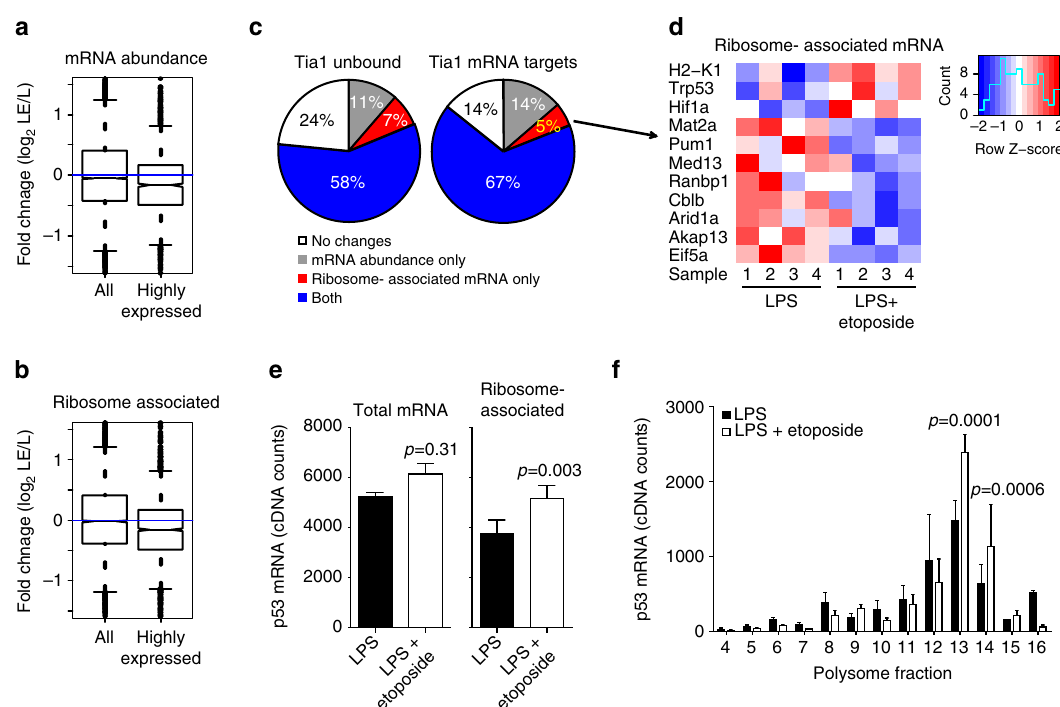
Fig. 4 DNA damage induces mRNA translation of p53 in B cells. a , b Global analysis of changes in mRNA abundance ( a ) and mRNA association with ribosomes ( b ) after treatment with etoposide of LPS-activated B cells. Box plots were generated with data from all genes or from only a selection of highly expressed genes. These genes were selected after calculating the mean number of normalized reads annotated to each gene in our mRNAseq and in our PolyRibo-3 ′ RNA-seq libraries. Then, windows of expression were generated by adding or subtracting 1000 counts (mRNAseq window in log2 is 11.09 < 11.63 (mean) < 12.03; PolyRibo-3 ′ RNA-seq window in log2 is 9.13 < 10.61(mean) < 11.32). Fold change equal to 0 is marked by the blue line. Wilcox test was performed comparing all genes vs. highly expressed genes. In both cases P < 2.2 × 10 − 16 . c Proportion of Tia1 mRNA targets (de fi ned as those mRNAs with 50+ unique cDNA counts mapped to the 3 ′ UTR in our Tia1 iCLIP experiments) and non- targeted mRNAs with a differential change in any heavy fractions that were also identi fi ed as differentially expressed at total mRNA abundance only, at ribosome-associated mRNA level or both. d Heatmap showing ribosome-associated mRNA abundance of Tia1 mRNA targets with a differential change in any heavy fractions and in mRNA translation. Numbers relate to each biological replicate. e Total cellular mRNA and ribosome-associated mRNA levels of p53 in LPS-activated B cells treated or not with etoposide quanti fi ed by mRNA-seq and PolyRibo-3 ′ RNA-sequencing. f Polysome pro fi le of p53 mRNA from PolyRibo-3 ′ RNA-seq experiments. Four biological replicates were analyzed in both mRNA-seq and PolyRibo-3 ′ RNA-sequencing experiments. Data in e , f are shown as mean + s.d. P adjusted values obtained after multiple testing correction ( P adj < 0.01 was used as threshold of signi fi cance) are shown in e ,